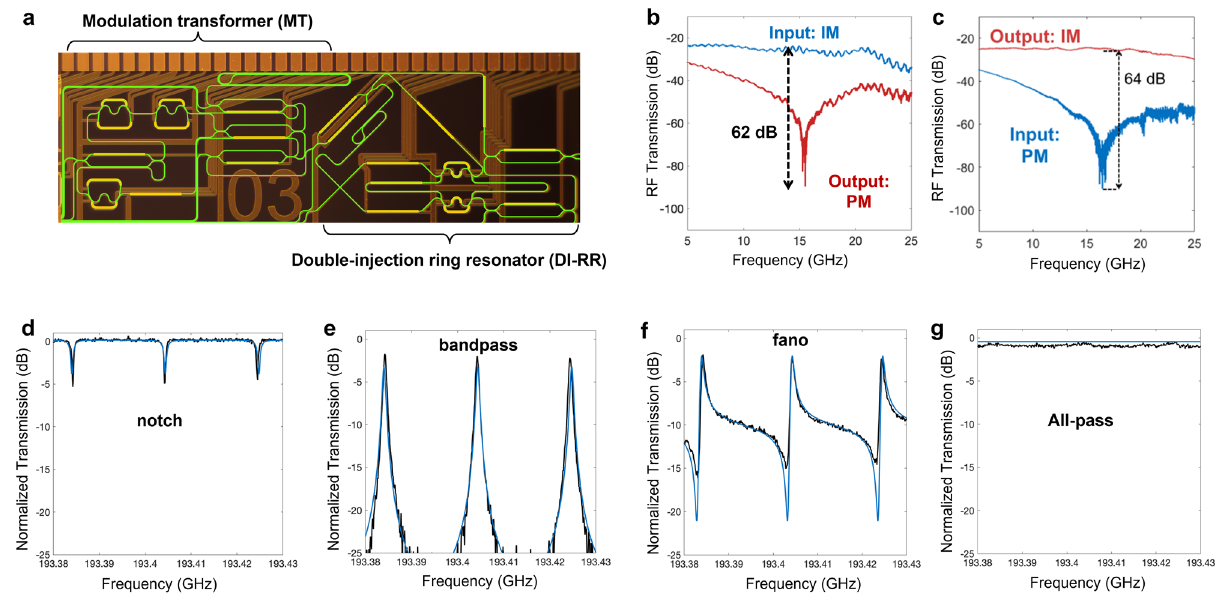
Fig. 2 | Programmable integrated MWP circuit. a The optical image of the pro- grammable photonic chip with outlined waveguide leads, containing of a mod- ulation transformer (MT) and a double-injection ring resonator (DI-RR). The MT consistsofaspectralde-interleaverusedtoisolateoneRFsidebandfromtheentire modulatedspectrum.Thephaseshifterandtunablecouplerareusedtocontrolthe phase and amplitude of the isolated sideband. Modulation transformation is achieved after recombination at the output. (see Suppplementary Information A for details of the MT.) b Experimental result of intensity-to-phase modulation (IM-